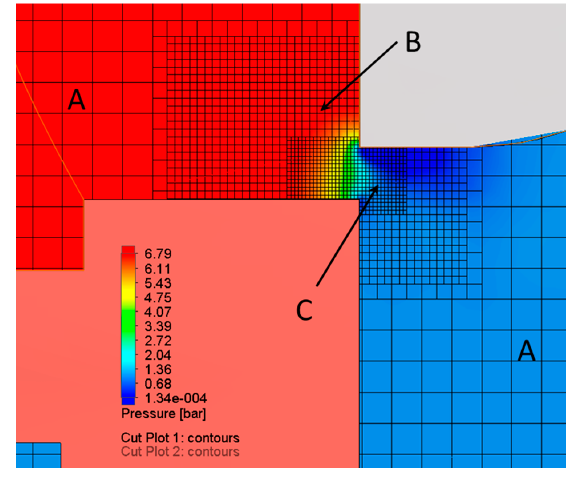
Figure 9. Pressure field with cell refinement across a hole with 2 L/min and lift of 0.35 mm. Two concentric local regions B and C across the metering edge were meshed with a finer grid.